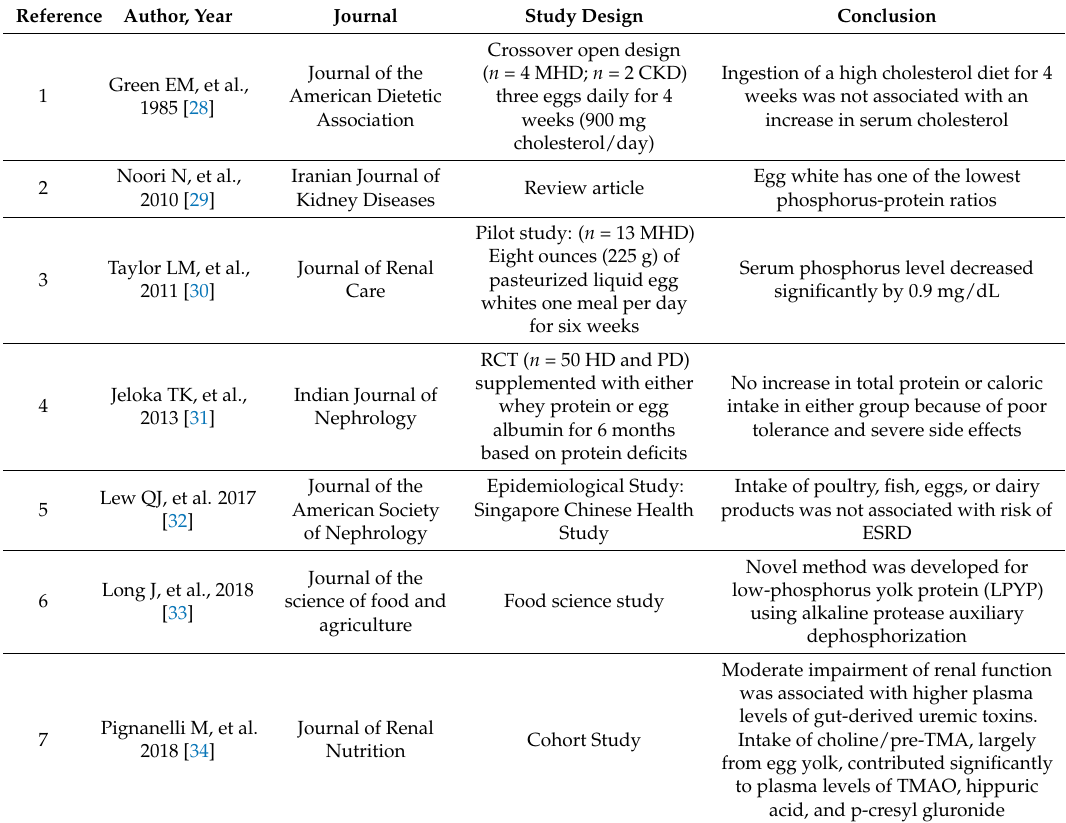
Table 1. Articles of interest discussed in current